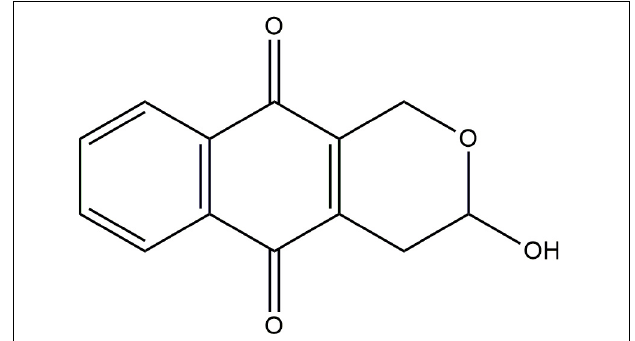
FIGURE 1 | Chemical structure of